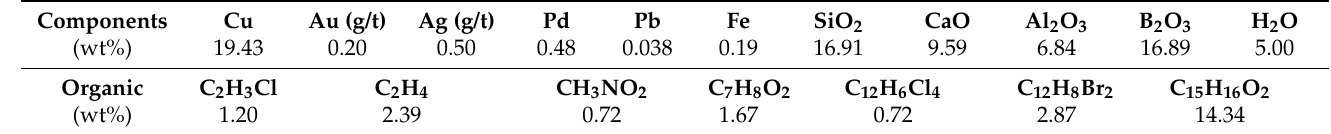
Table 1. Chemical compositions of the cutout of the copper-clad laminate.